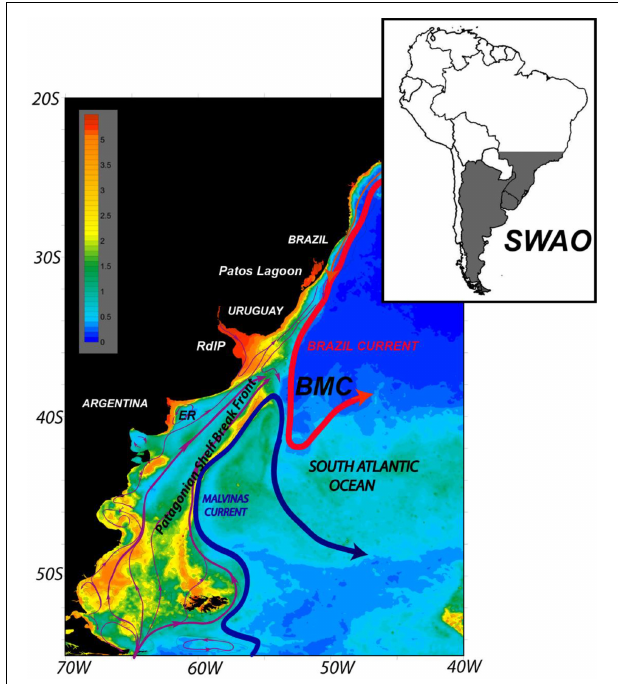
FIGURE 1 | Schematic circulation in the southwest South Atlantic Ocean (SWAO). Concentration of surface chlorophyll-a (mg m - 3 ) from the SeaWIFs radiometer (austral summer average) is shown in the background colors. The magenta lines indicate the schematic shelf circulation. The Brazil-Malvinas confluence (BMC) region is shown. El Rincón estuary is shown as ER. From Franco et al. (2017), with